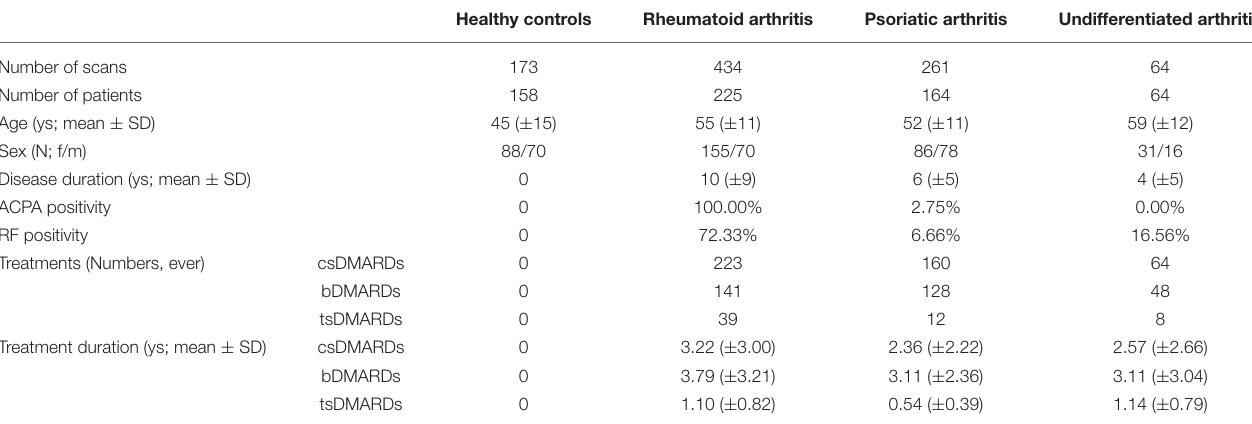
TABLE 1 | Patients and controls.